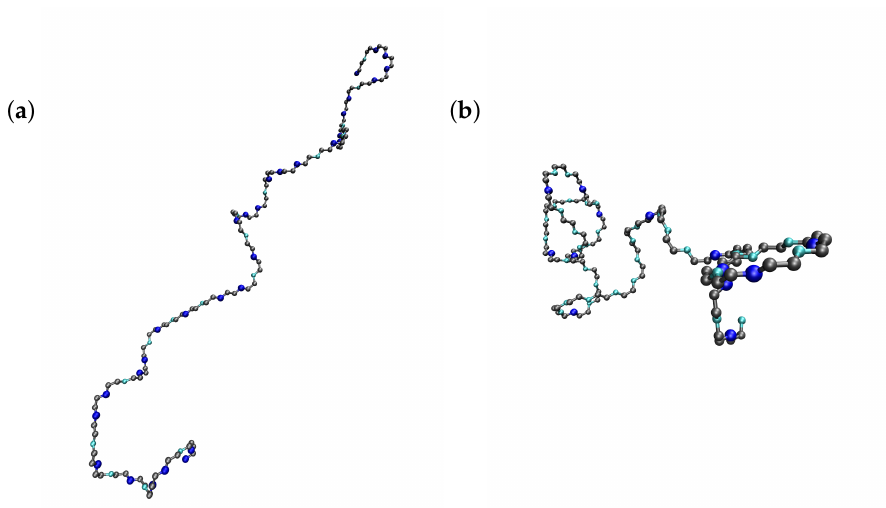
Figure 4. Two snapshots of Monte Carlo simulations with p K = 9, (cid:101) t = 1, u g = 0, σ = 10 and pH = 4 ( a ) and pH = 8 ( b ). Note that elongated conformations are promoted at low pH as a consequence of polyelectrolyte global charge